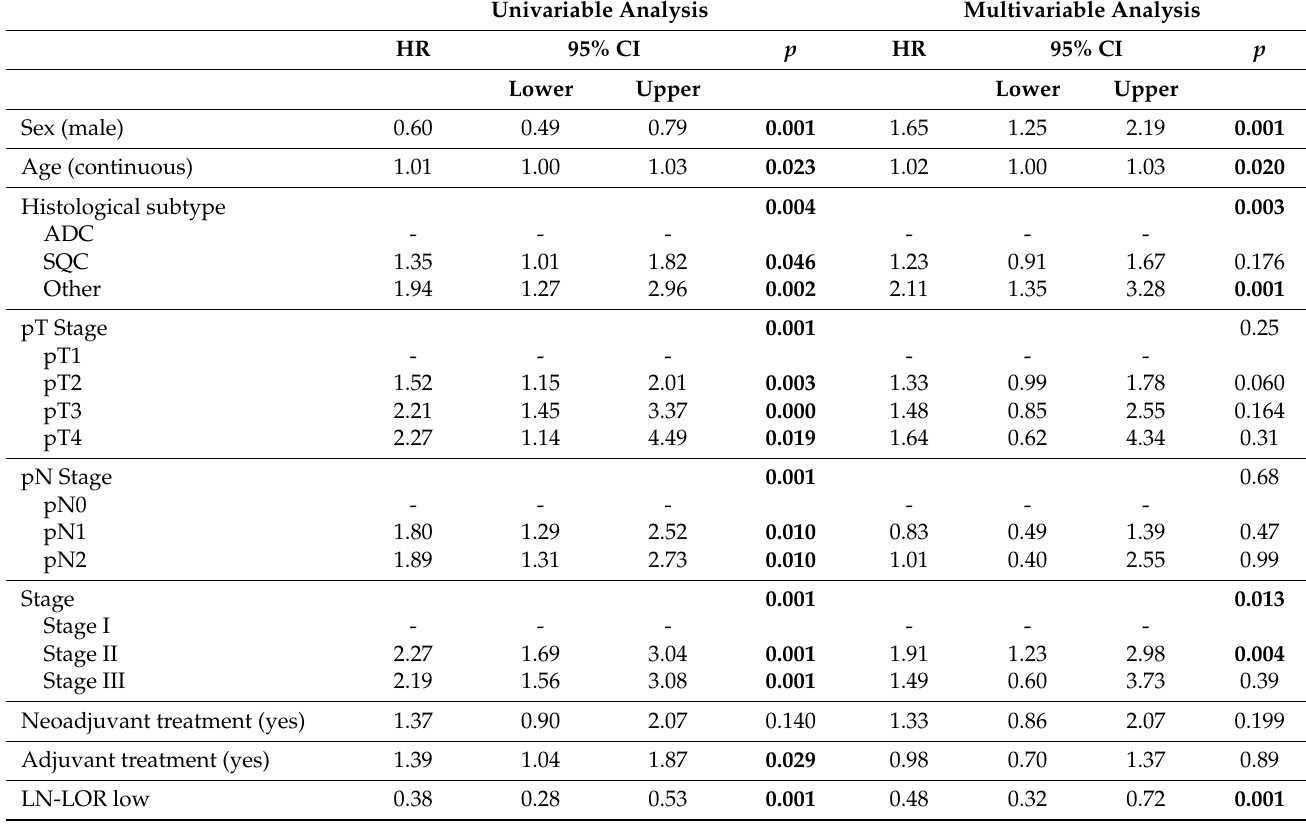
Table 3. Univariable and multivariable Cox regression survival analysis for clinical and pathological factors in a cohort of 944 patients undergoing lobectomy for stage I-III NSCLC. Univariable Analysis